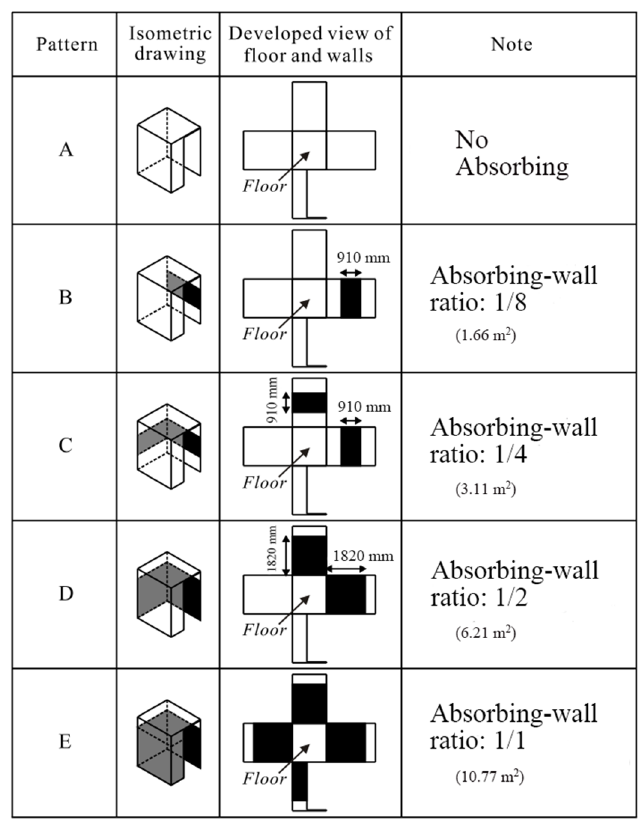
Figure 2. Five absorption patterns used for the pair comparison experiment. Polyester nonwoven absorbers installed at the colored positions. Table 1. Results of the measurement in the front chamber (O) and five absorption patterns